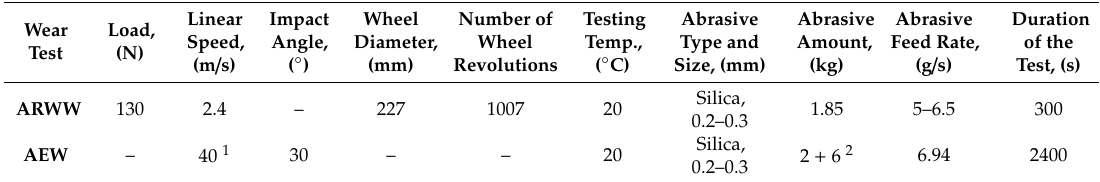
Table 4. Parameters of the abrasive wear tests.